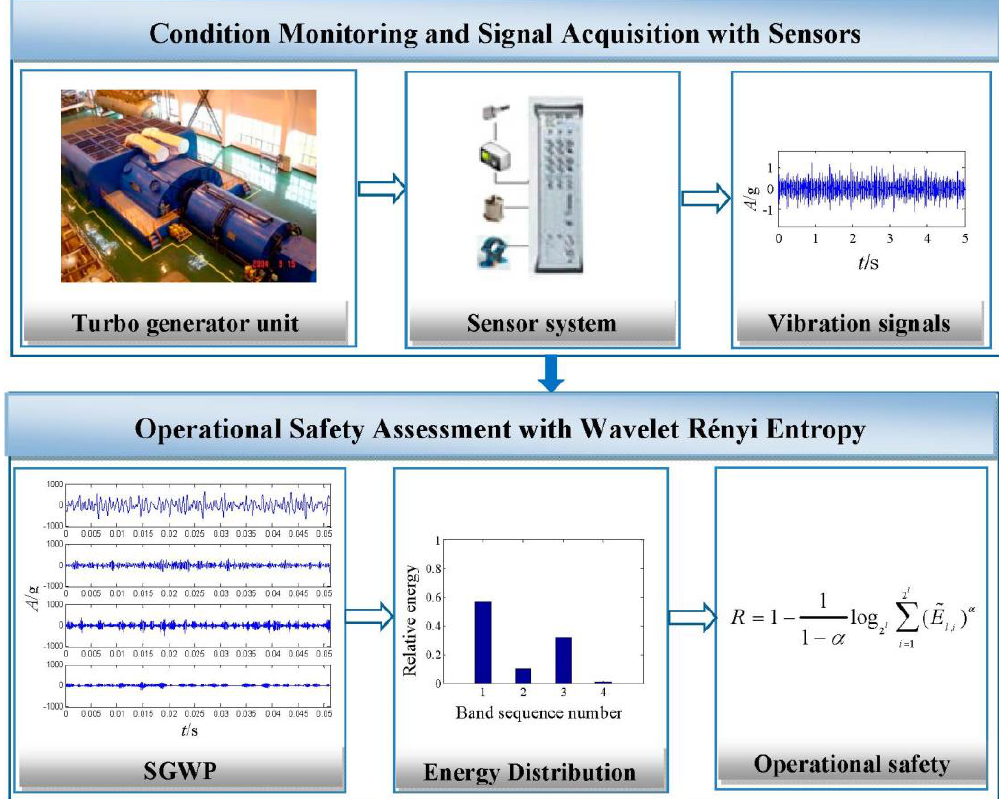
Figure 2. Illustration of operational safety assessment with wavelet Rényi entropy from sensor-dependent vibration